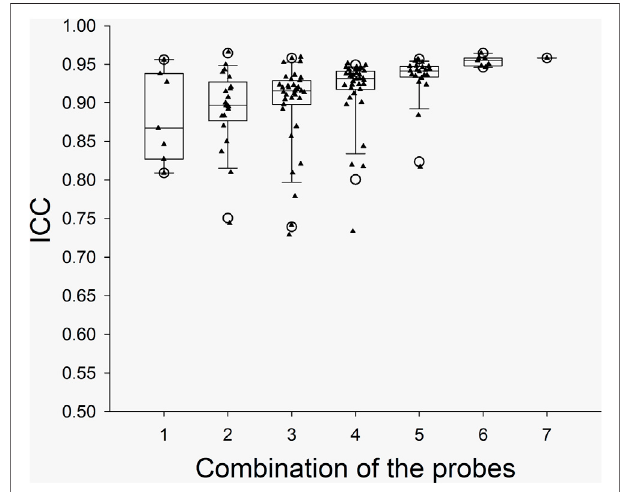
FIGURE 2 | Boxplots for the ICC between CVC values during the Arm Trials with the various probe combinations. X axis: the number of probes for the combinations. The calculated “ Minimum ” and “ Maximum ” values are indicated by open circles. The data below Minimum or above Maximum were outliers.